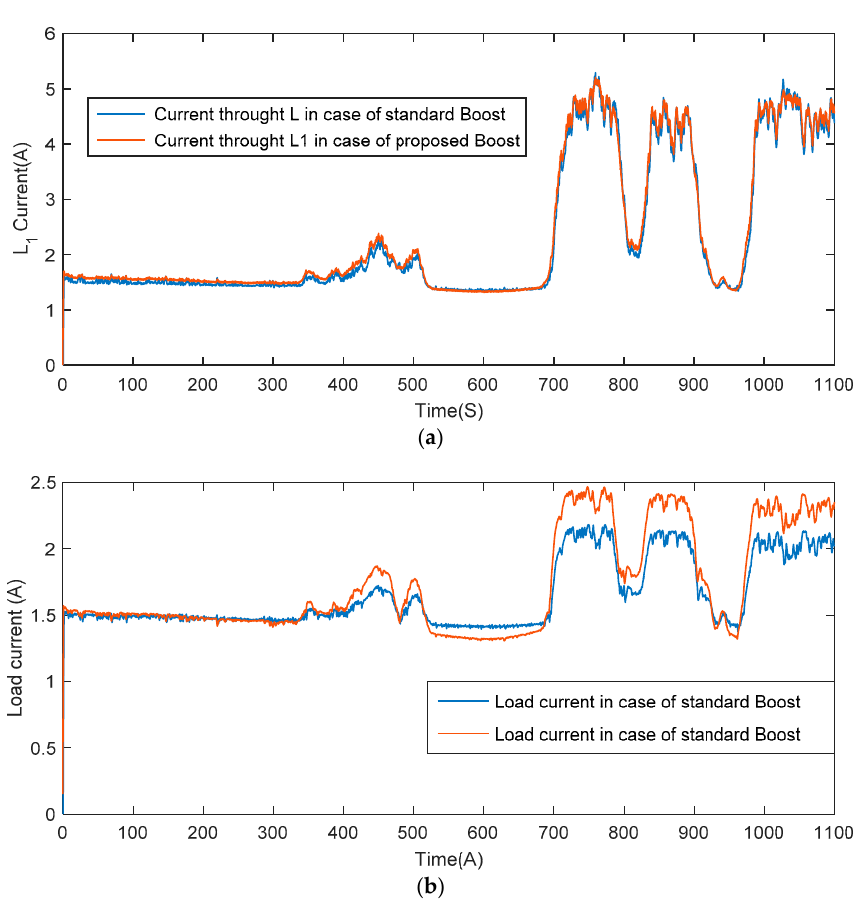
Figure 19. ( a ) Current through L 1 , ( b ) load current. In Figure 20 the measured power transferred to the load for both circuits is presented.